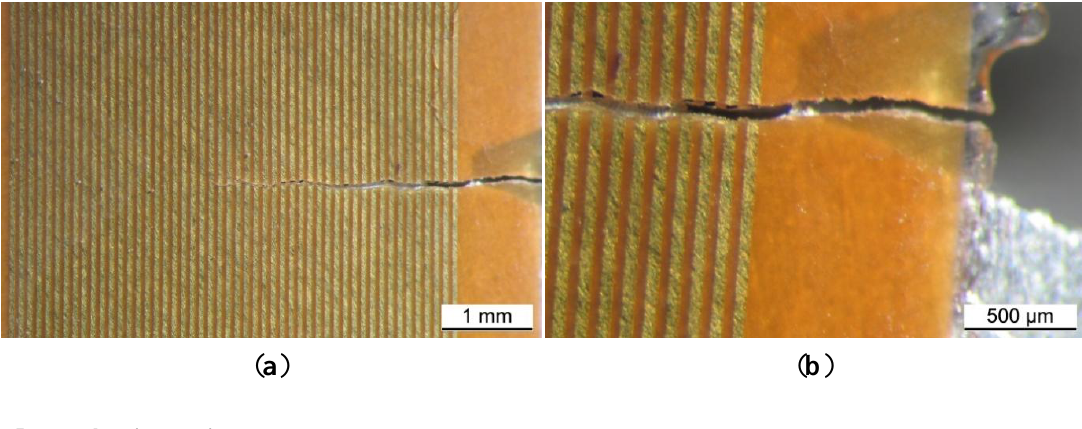
Figure 9. ( a ) Micrograph (20×) of the crack propagation gage (about 30 strands are broken); and ( b ) detail (50×) of the crack propagation gage at the notch root area: the fatigue crack crosses only the first 4 strands of the crack propagation gage. Each strand rupture is related to the increment in crack propagation (with constant distance between the